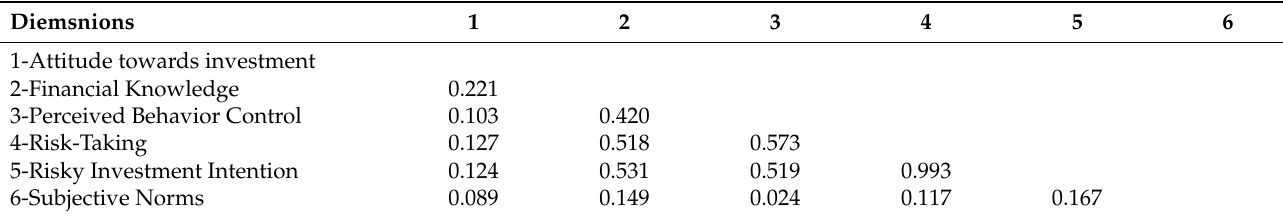
Table 3. Heterotrait-monotrait ratio (HTMT)—Matrix.